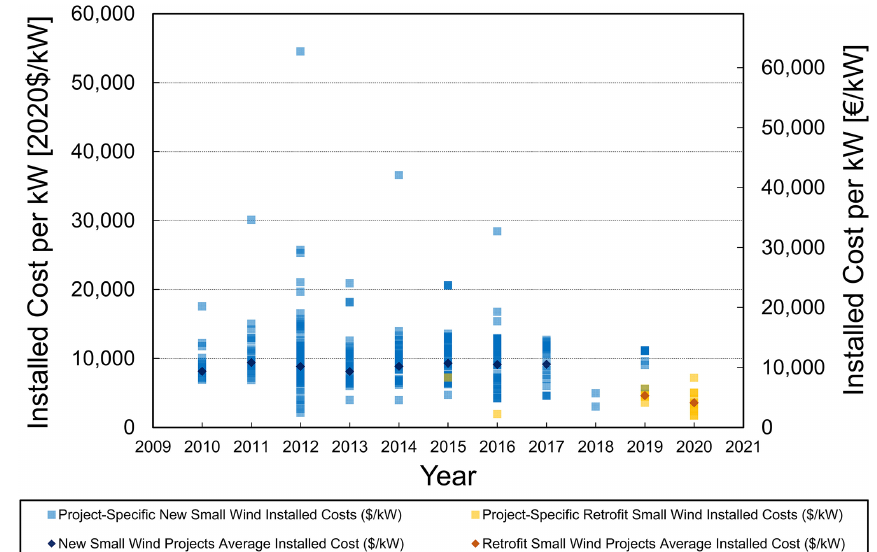
Figure 6. Installed cost per kilowatt for newly installed or retrofit projects in the United States (Orrell et al.,